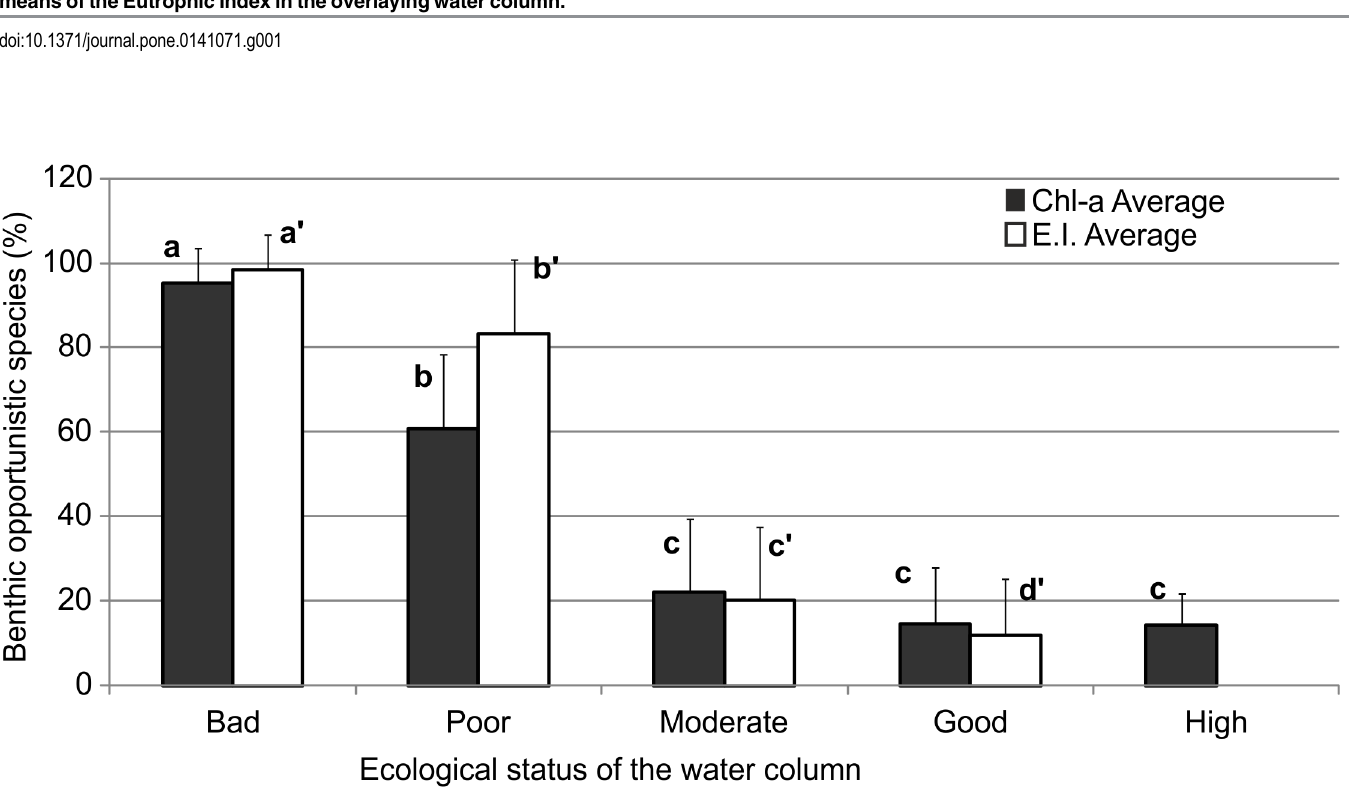
Fig 2. Average percentage ( ± SD) of benthic opportunistic species (ES50 0.05 < 10) in each Ecological Status of the water column as indicated by the Chl- a scale or the Eutrophic Index. Statistically significant differences between groups (p < 0.05) in the post hoc Tukey tests for each ANOVA test are indicated by differences within the following groups of letters: Chl- a (a – c) and EI (a ’– d ’ ).